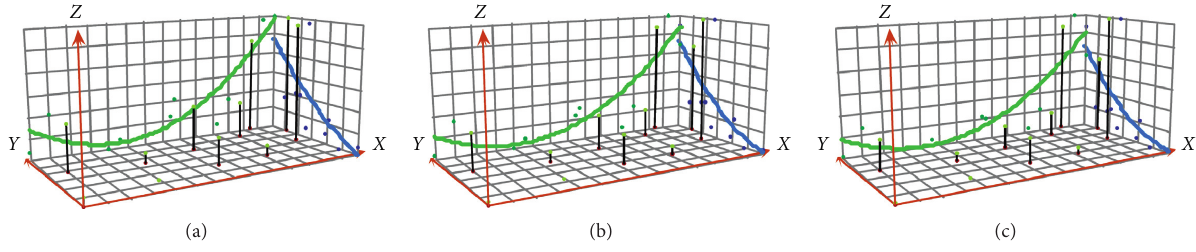
Figure 5: The trend distribution of listed companies in (a) 2008, (b) 2013, and (c)